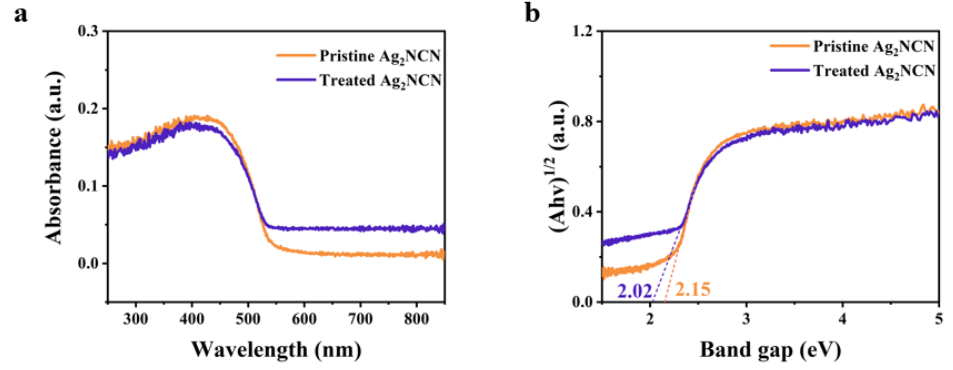
Figure 4. ( a ) UV diffuse reflectance and ( b ) K-M equation curve of Ag 2 NCN before and after treatment.